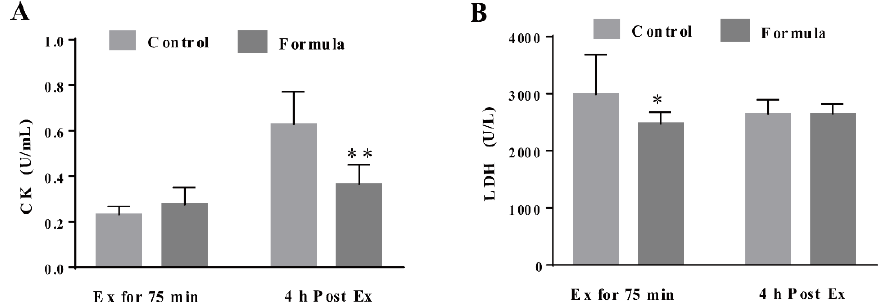
Figure 6. The injury-related biochemical parameters, CK ( A ) and LDH ( B ), in the serum of each group after Ex for 75 min and 4 h post Ex for comparison among groups at the same time course.